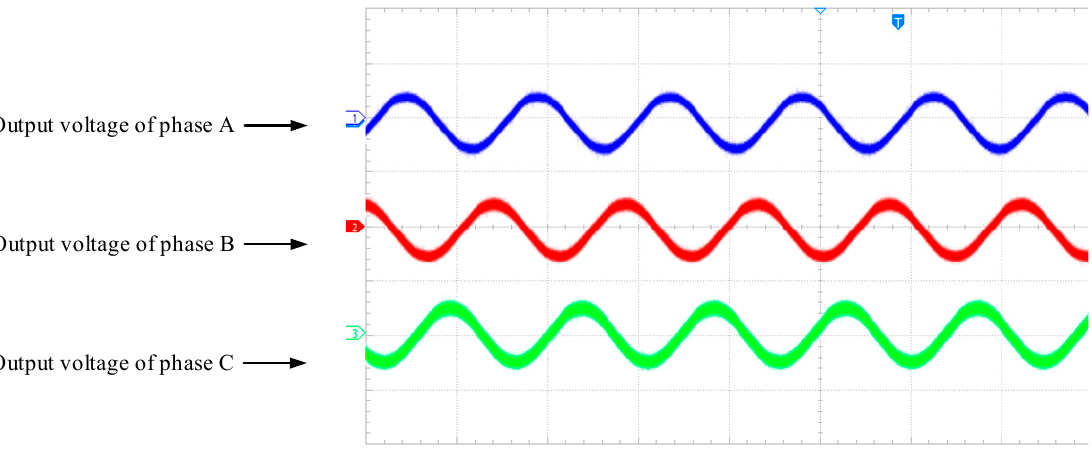
Figure 11. Waveform of output voltage of three phases of MMC.